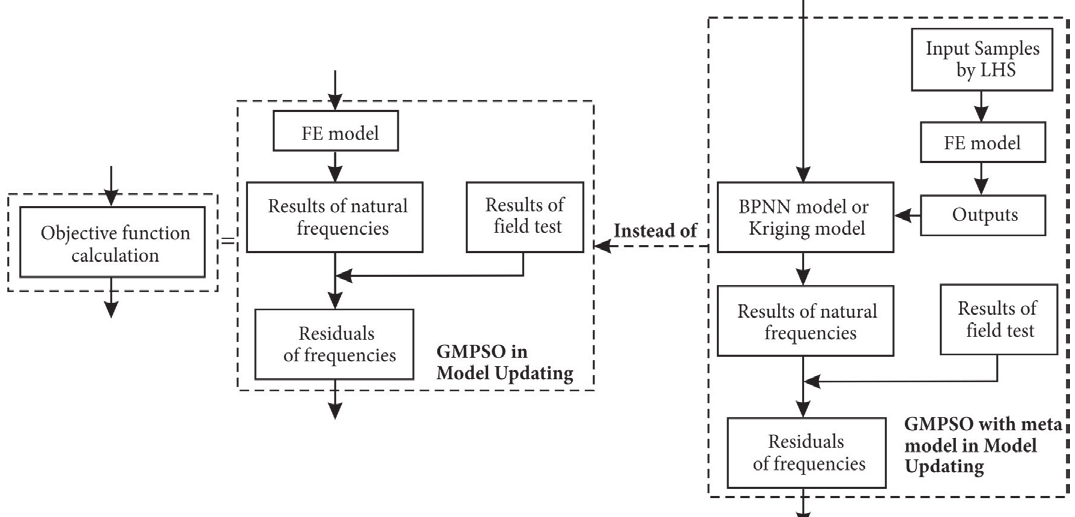
Fig. 3. Meta model integrated with Gaussian mutation particle swarm